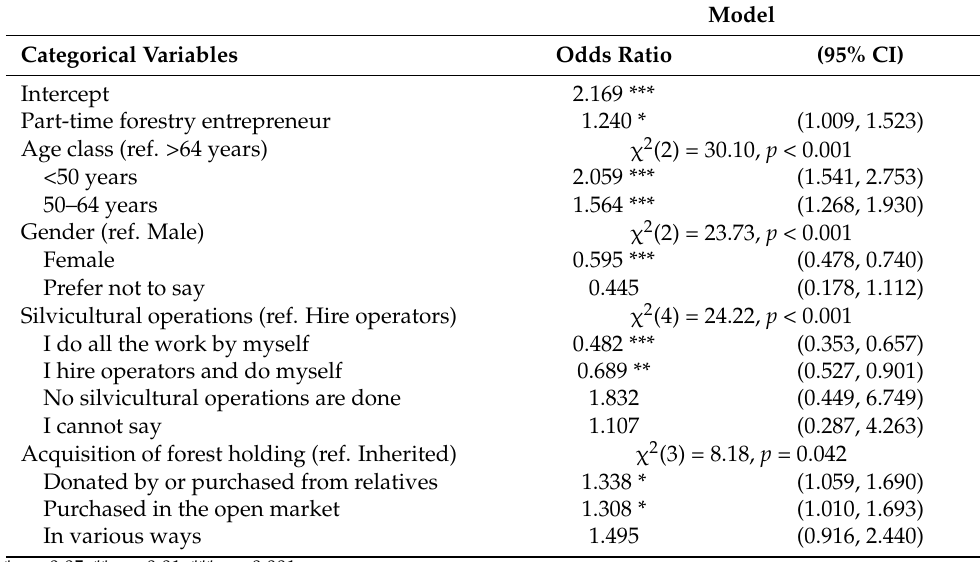
Table 12. Logistic model (odds ratios and 95% CI) on forest owners’ probability of assignment to the group Commercial picker or Permit provider (n = 1466) based on their utilisation of NTFPs. The reference category is the group Household user (n = 668). χ 2 is the joined Wald χ 2 test of the categorical effects, the degree of freedom in